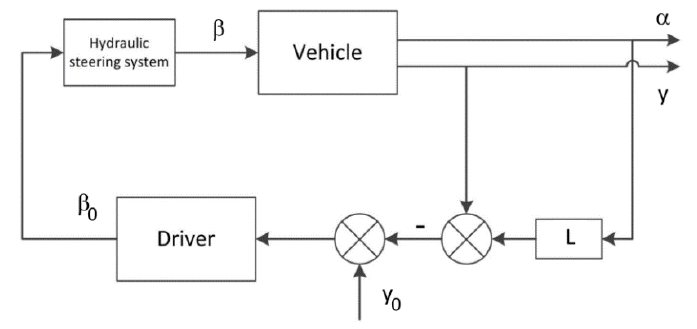
Figure 8. Diagram of steering control loop with driver input as lateral displacement and yaw angle.